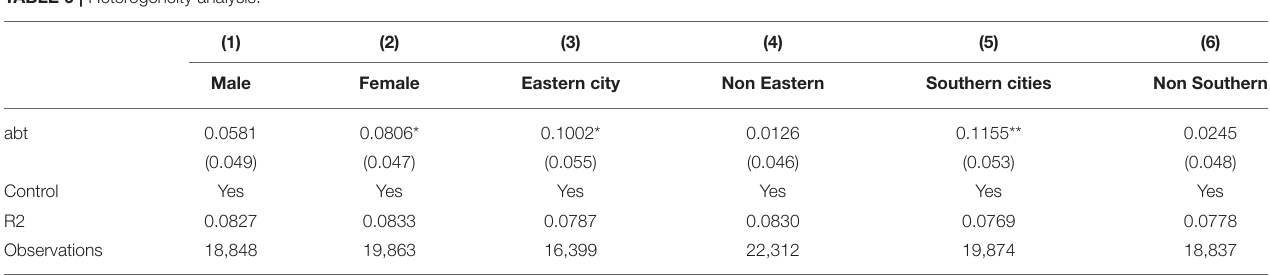
TABLE 6 | Heterogeneity